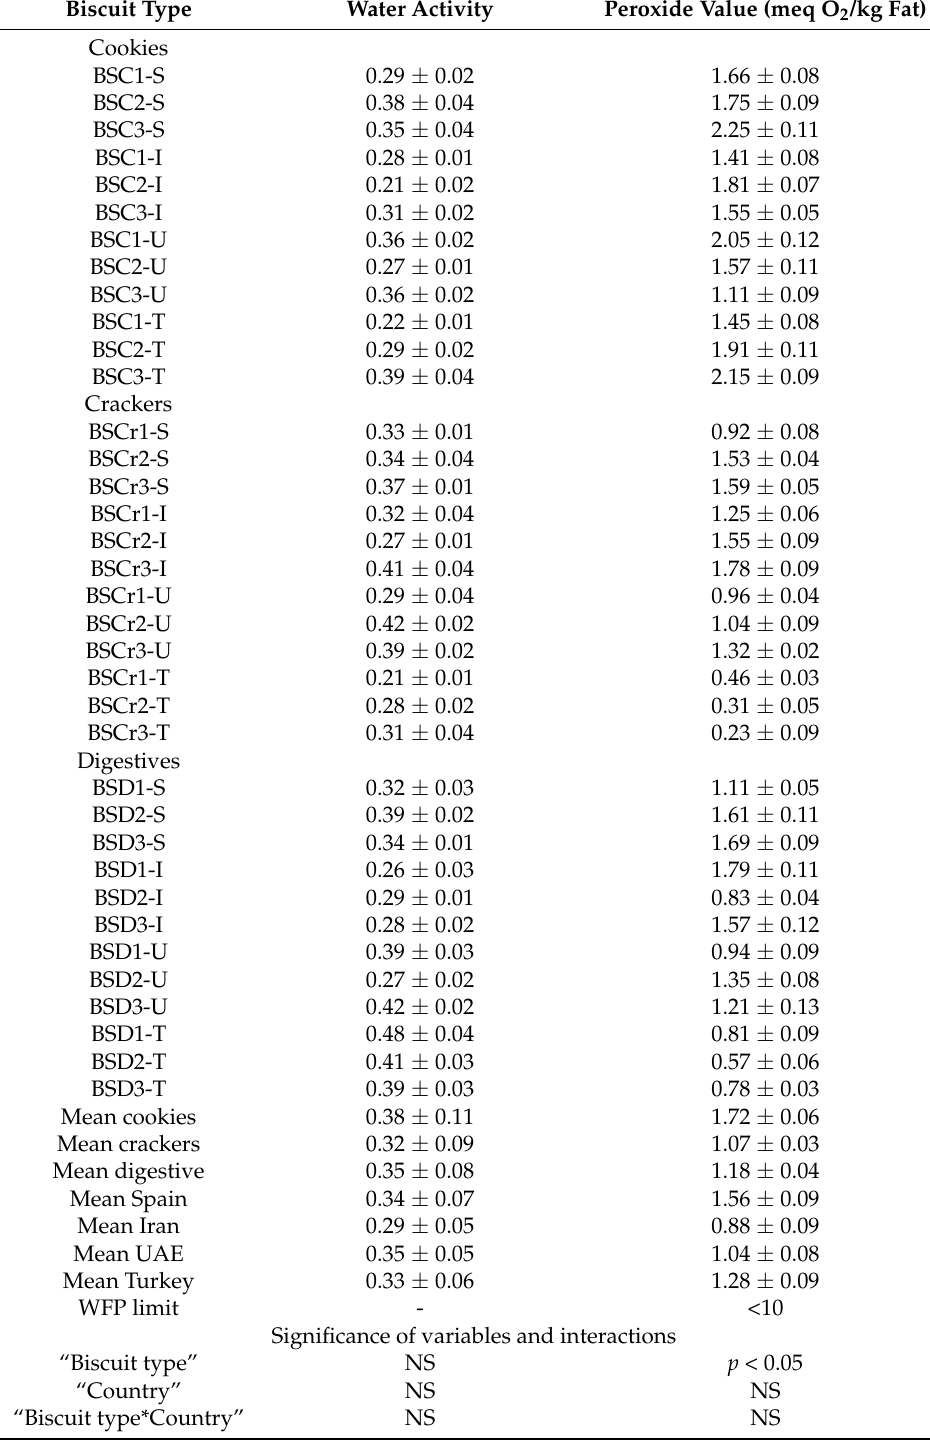
Table 2. Water activity and peroxide value of biscuits marketed in Basrah,